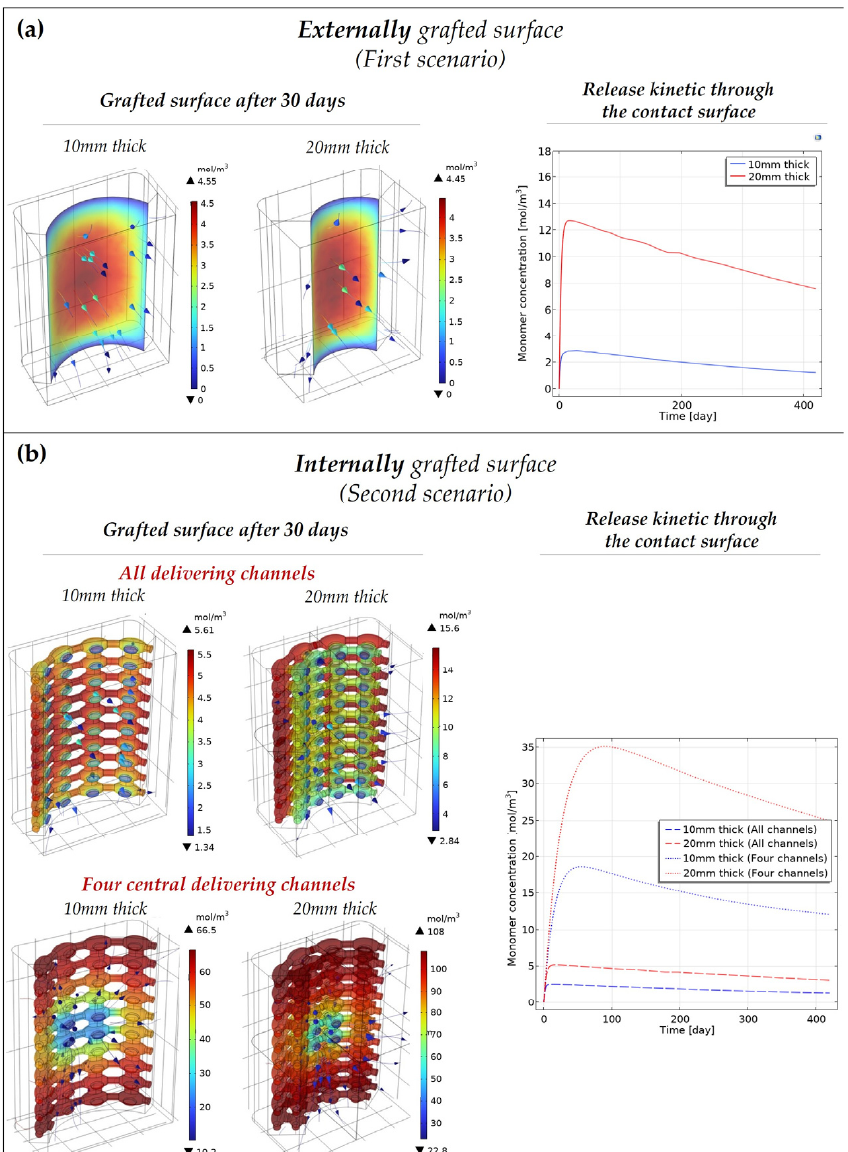
Figure 4. Release kinetic of the bioactive molecules through the contact surfaces (i.e., external grafted surface in the first scenario ( a ) and the open delivering channels in the second scenario ( b )) of the scaffold. Depicted on the left is the degradation behavior of the grafted surface—( a ) internal (first scenario) and ( b ) external (second scenario)—after 30 days. The release kinetic of the degradation products through the contact surfaces is reported on the